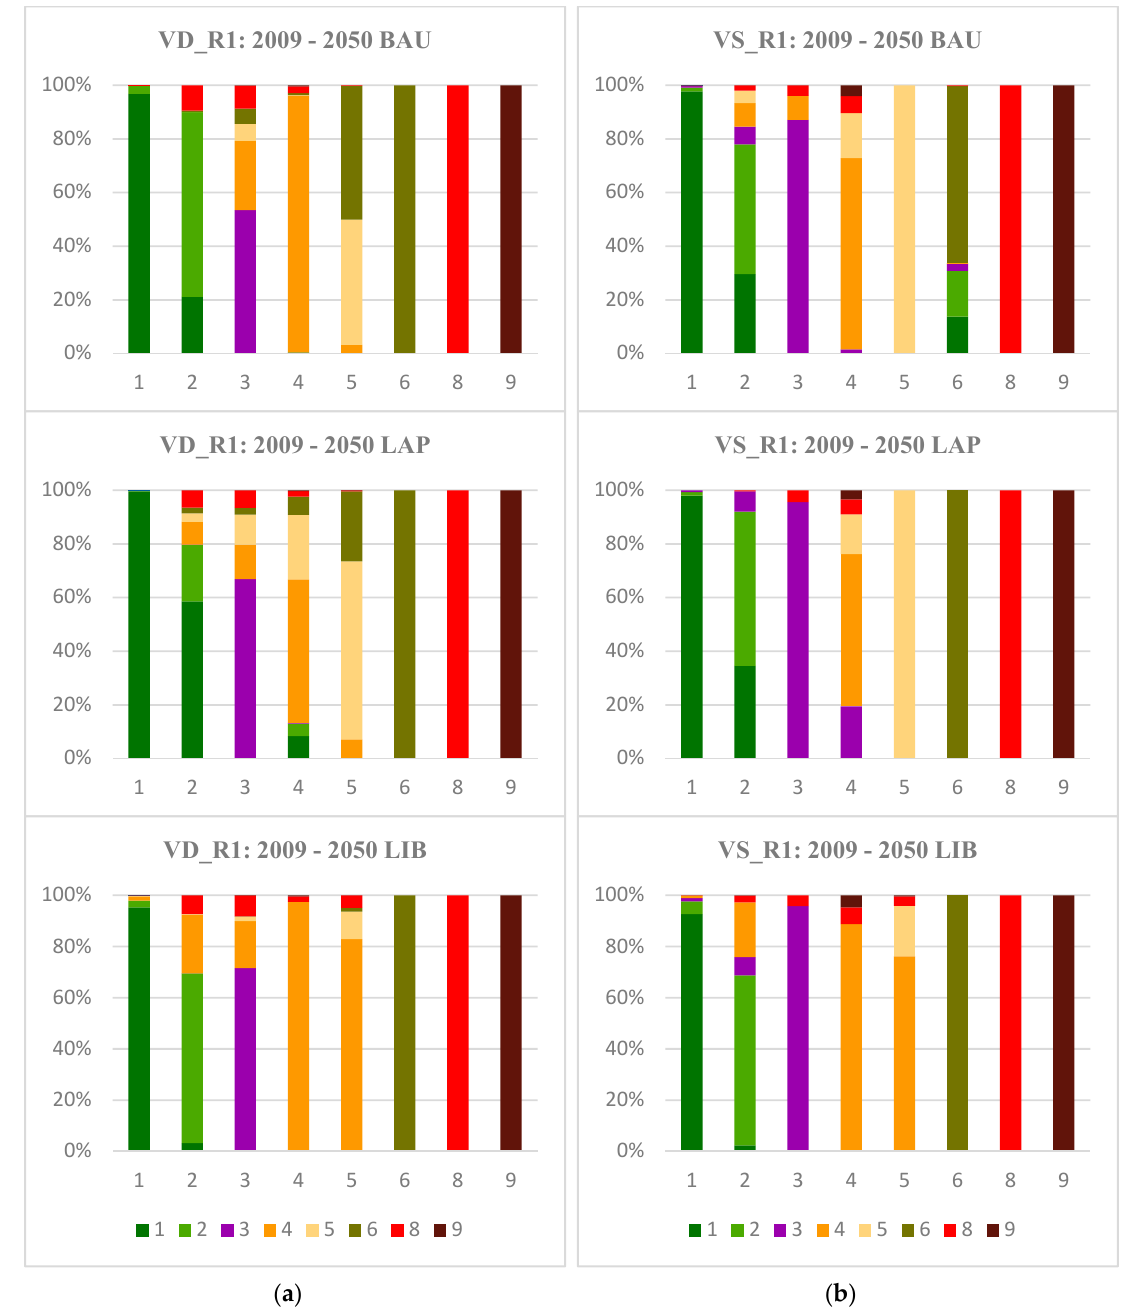
Figure 5. Percentage of land use composition in 2050 (BAU, LAP and LIB scenarios) out of the existent in 2009, in ( a ) VD_R1 and ( b ) VS_R1. Each stacked bar represents the share of land use type in 2050 (BAU, LAP and LIB scenarios) for each land use types observed in 2009. Colours indicate each land use type. The stacked bar percentage information was obtained by cross-tabulation between the observed 2009 and each land use scenario. 1: closed forest; 2: open forest; 3: permanent crops; 4: intensive agriculture; 5: extensive agriculture; 6: shrubland; 8: urban; 9: industry.